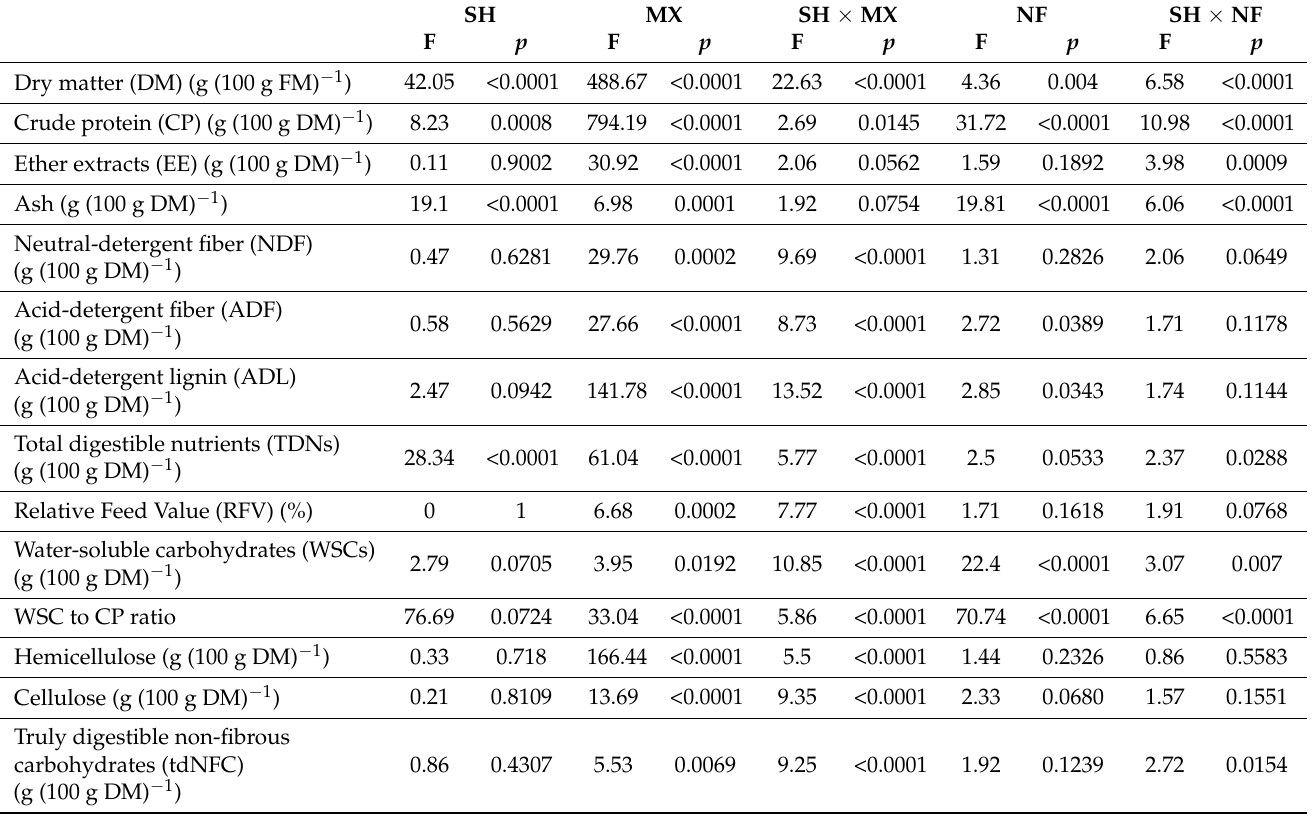
Table 1. F statistic and p -values of the general linear mixed model applied to the variables measured in the herbage. Factors were the stage of harvest (SH): early, mid and late; the mixtures (MX): pure fertilized or unfertilized barley and pure faba bean whole biomasses and their 75:25, 50:50, and 25:75 mixtures (MX); and the barley N fertilization (NF), either fertilized or not, nested into the mixtures since the pure faba bean was not